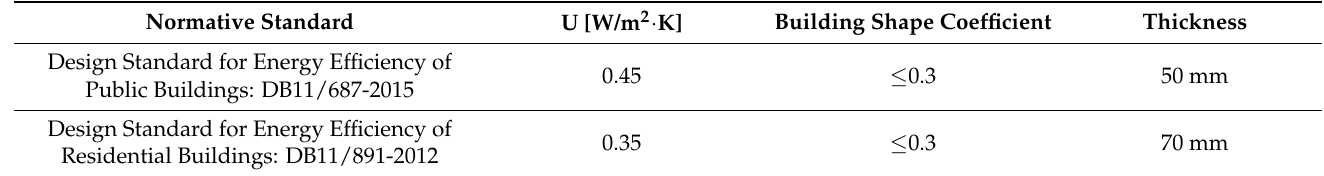
Table 8. Thickness of XPS Insulation Board.